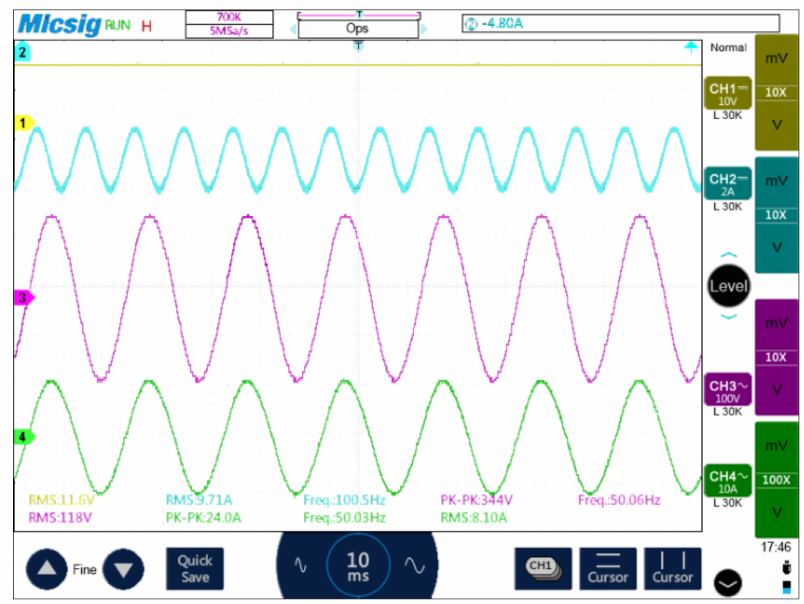
Figure 8. The input/output waveforms of the commercial 12 VDC–120 VAC inverter when the output was set to 100W: Yellow—Input supply voltage, Blue—Input current, Green—Output current, Purple—Output AC